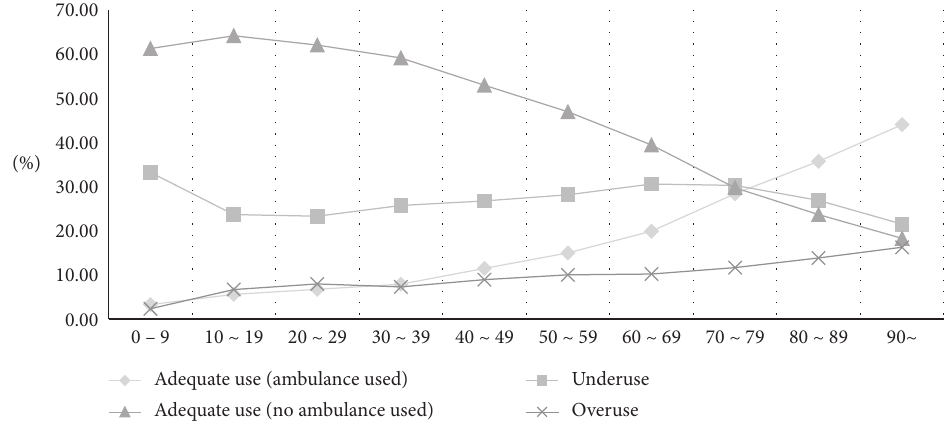
Figure 5: Comparison by age group. Older people use the ambulance more than the young. Under 9, underuse is the Table 3: Arrival time and month of patients, n (%).